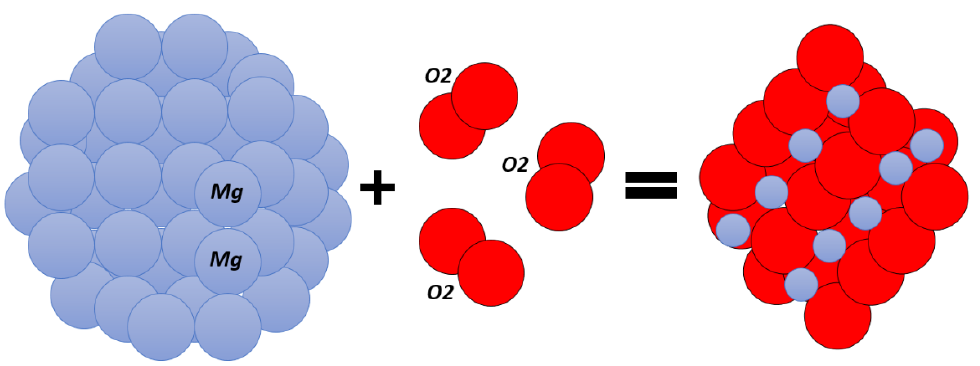
Figure 3. The formation of a chemical reaction.